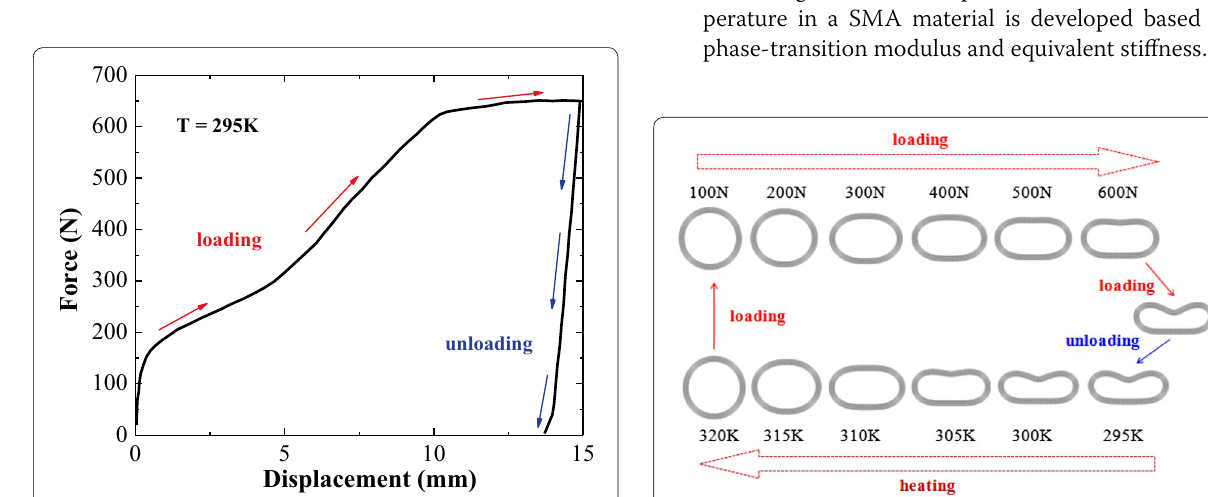
Figure 11 Curve of the applied force versus the displacement of punch head at 295 K